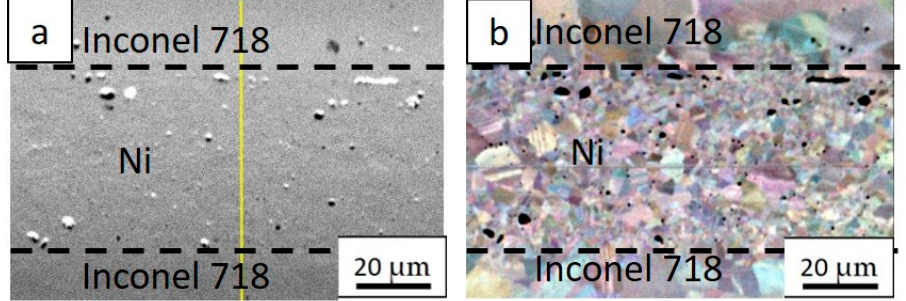
Figure 1. Inconel 718 Joint with Ni Nanomaterials as the filler metal: ( a ) SEM image; ( b ) forescatter detector image.